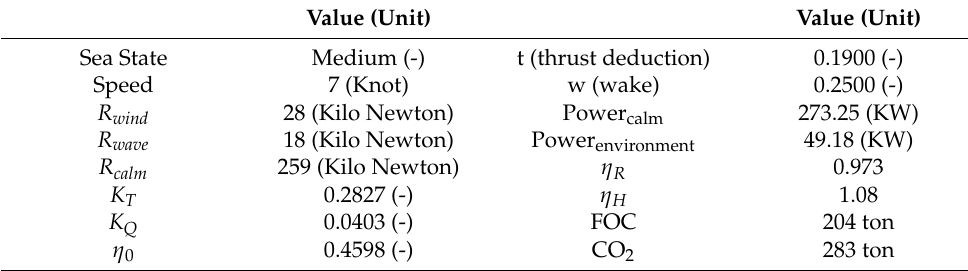
Table 4. Example data set for the fuel oil consumption estimation at stage 2.